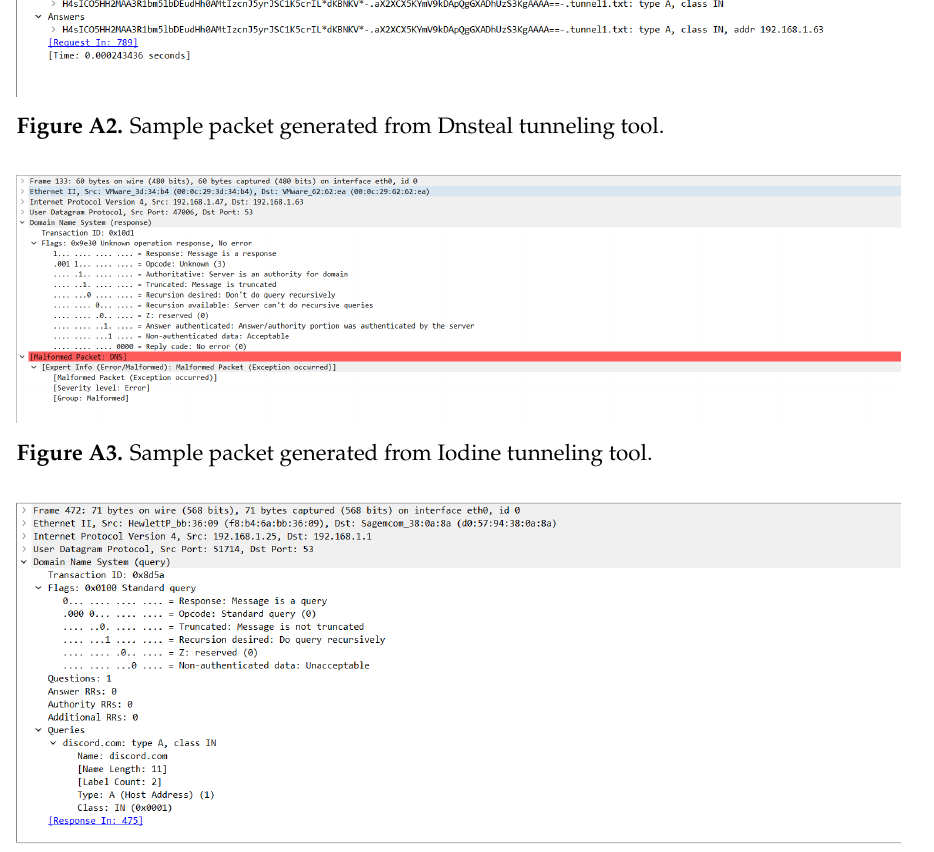
Figure A4. Sample packet generated from uninfected device.